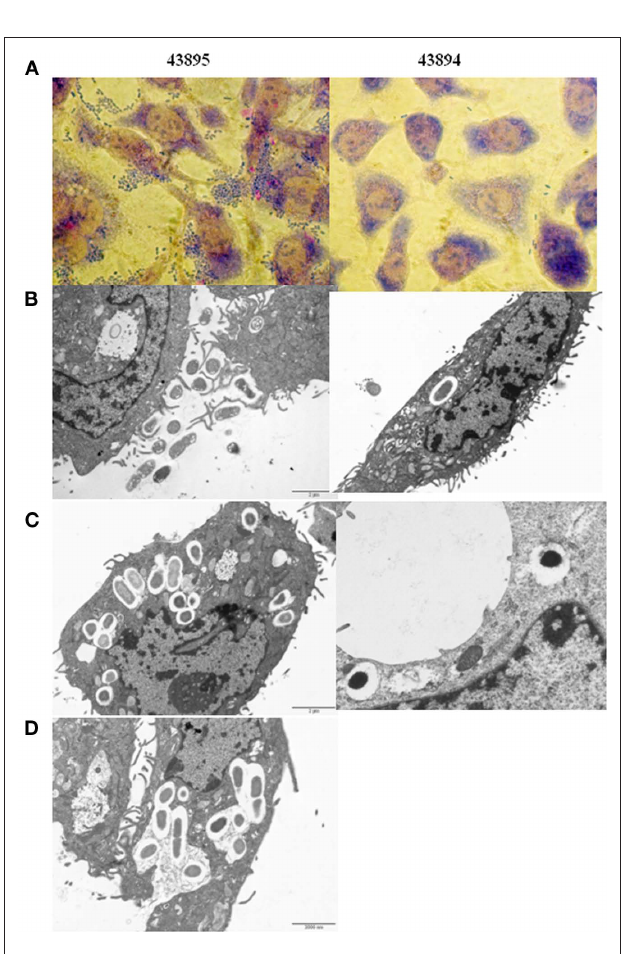
FigUrE 3 | Escherichia coli O15:H7 adheres to and enters the PBrE cells. E. coli O15:H7 43894 or 43895 were incubated with the monolayer of PBRE cells at 100 MOI for 4 h. More 43895 bacteria adhered to and were internalized by the PBRE cells compared to 43894. (A) Giemsa staining showing 43895 aggregative adherence pattern (inverted microscope, original magnification, × 1000). (B,C) Transmission electronic microscope showing extracellular and intracellular bacteria. (D) 43895 appeared to divide within the vacuoles of the PBRE cells (Original magnification, × 10000).